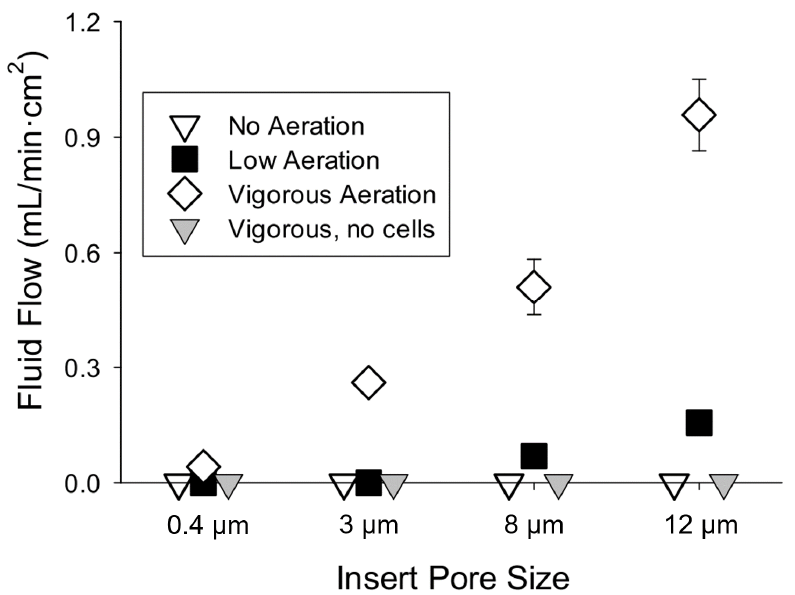
Figure 1. Fluid flow through epithelia prepared from mouse enterocytes and cell-free inserts and the relations with insert pore size and intensity of aeration. Enterocytes harvested from three mice were cultured on inserts with different pore sizes (N = 6 per size and aeration intensity). Fluid movement was measured as the volume increase in the apical chamber after exposure for 5 min to different intensities of aeration in both chambers.